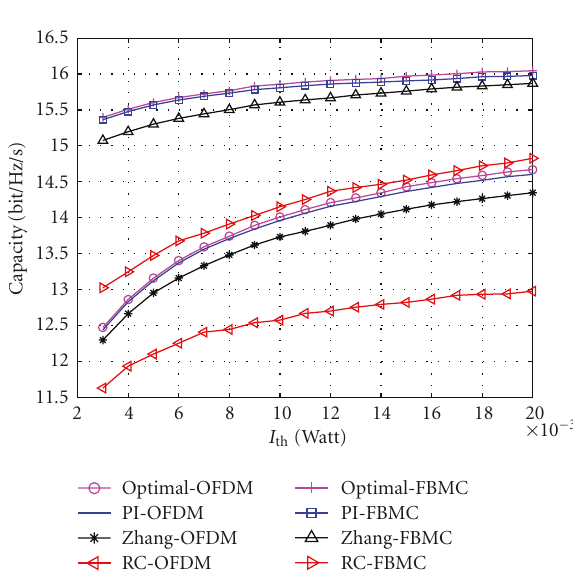
Figure 14: Achieved capacity versus allowed interference threshold for OFDM- and FBMC-based CR systems—one active PU